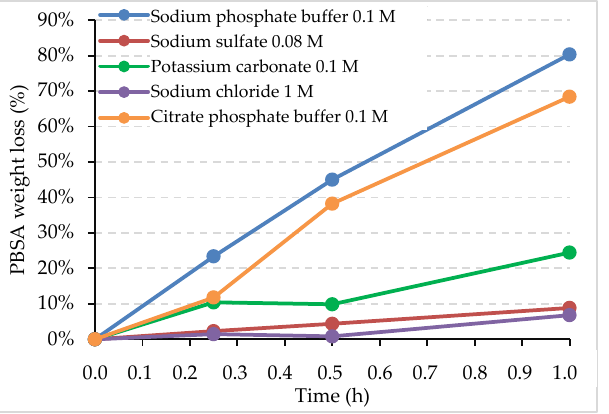
Figure 1. Weight loss (%) of PBSA by cutinase in the different triggering solutions as a function of the incubation time (hours). Table 2. Degradation rates (mg/h/cm 2 ) of cutinase on PBSA in the different triggering solutions; activity of cutinase (U/mL) in the different triggering solutions. The activity of cutinase in sodium buffer phosphate (i.e., the highest activity obtained) has been fixed as 100%. (n.a. — not available). Triggering